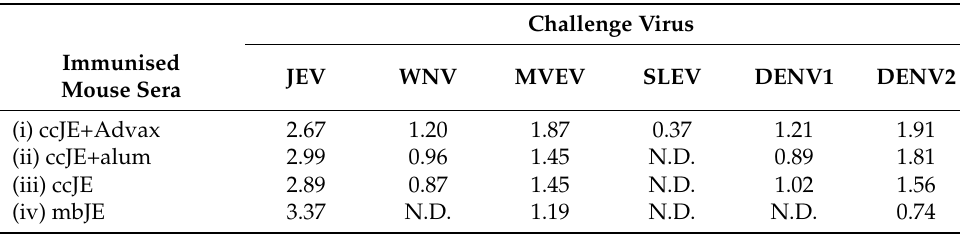
Table 1. Advax induces broad cross-neutralising antibodies against Japanese encephalitis virus (JEV) and other flaviviruses.